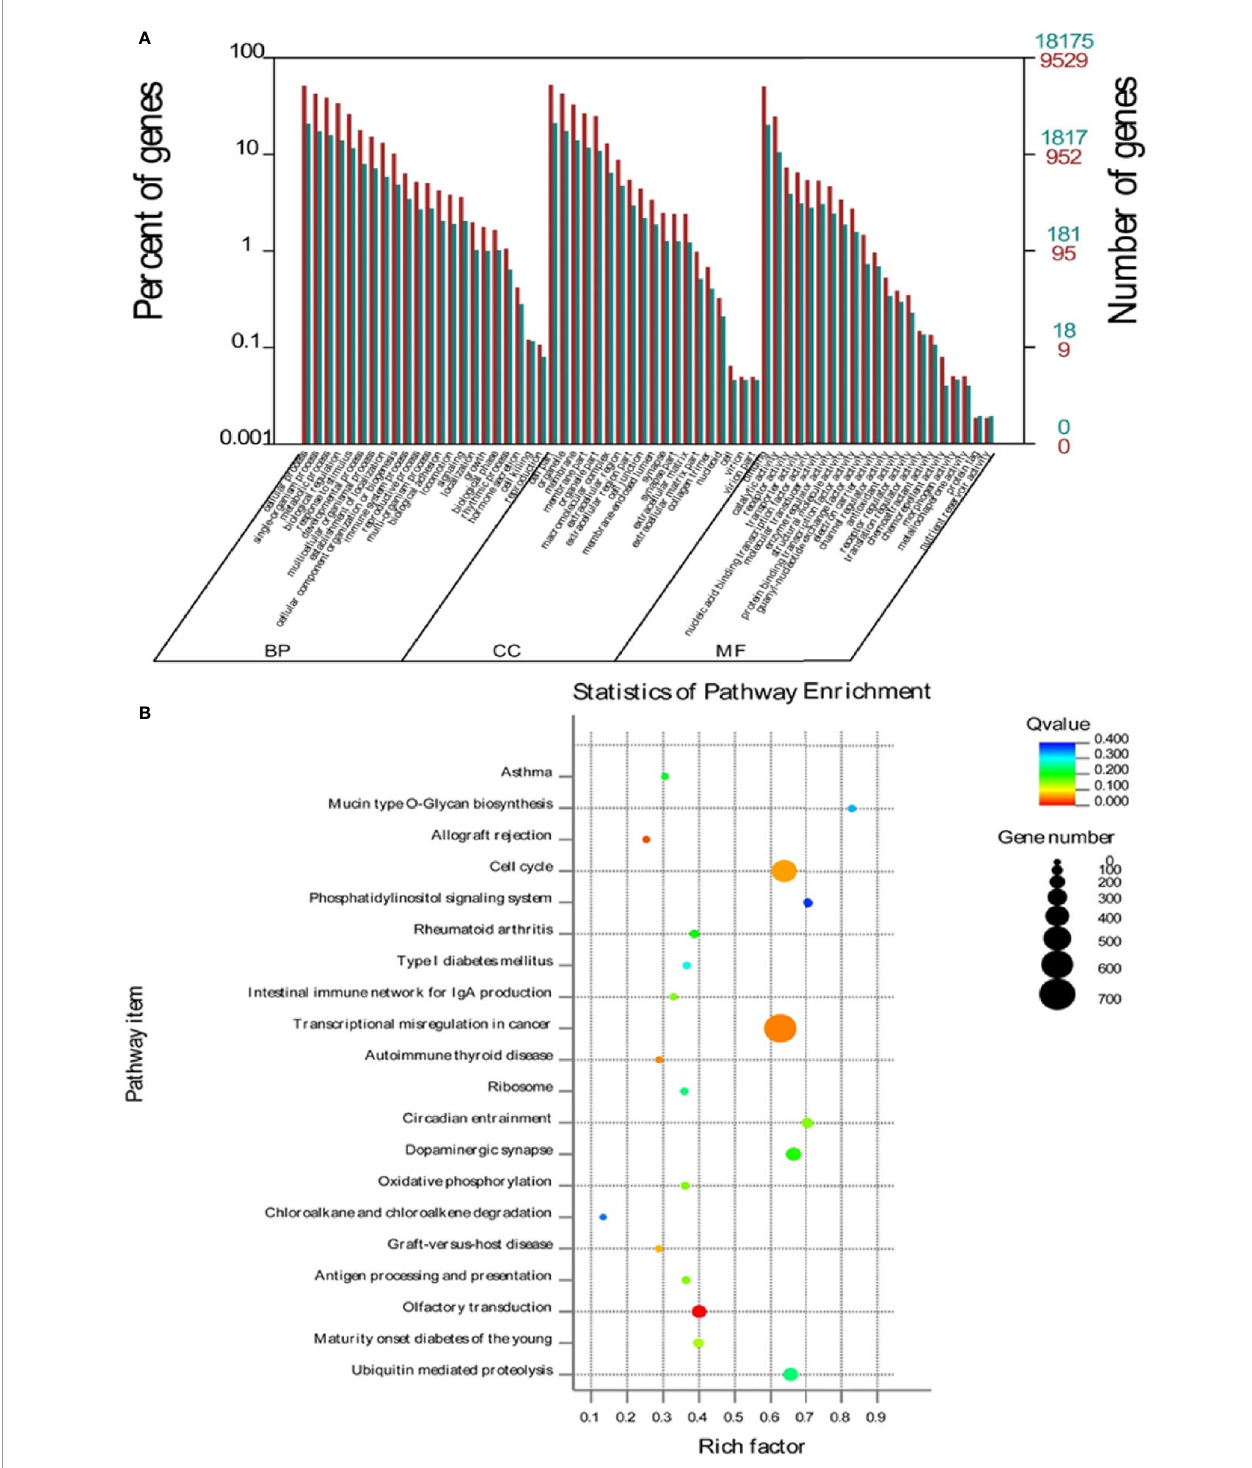
FIGURE 4 | GO and KEGG enrichment analysis of differential miRNA target genes. (A) The target genes of miRNA involve BP (biological processes), CC (cellular components), and MF (molecular functions). (B) The closer the Q-value is to zero, the more signi fi cant the particular GO term associated with the group of genes; the closer the Q-value is to one, the opposite. The closer the Q-value is to 0, the more signi fi cant the particular GO term associated with the group of genes; the closer the Q-value is to one, the